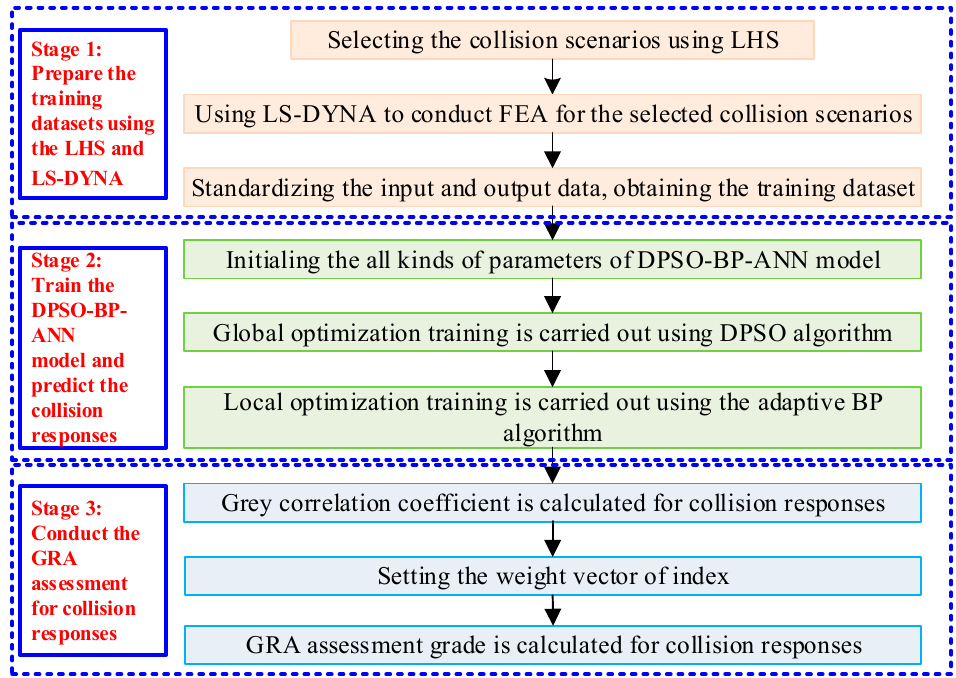
Figure 1. Research framework.